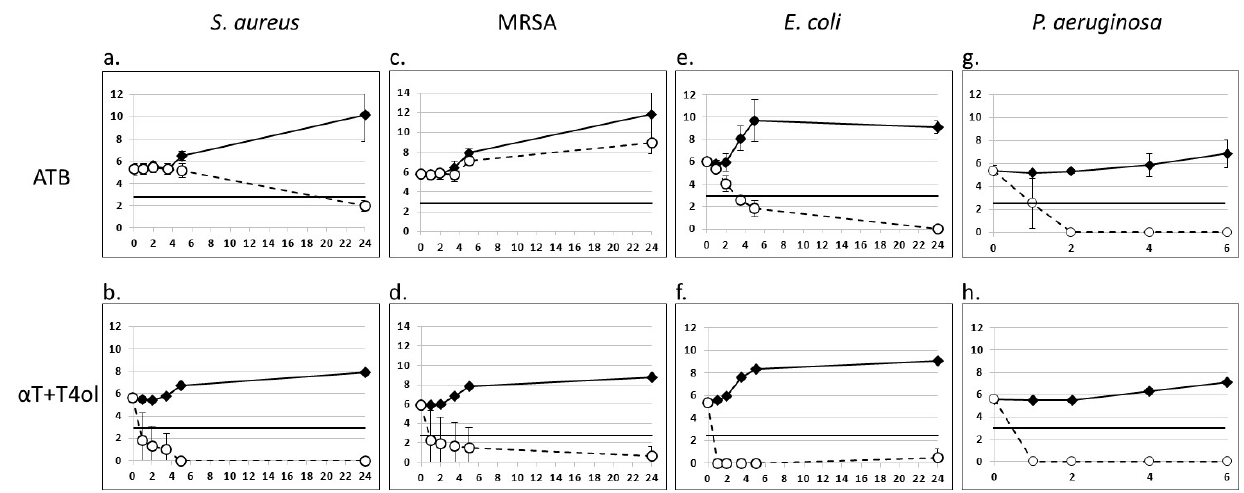
Figure 2. Time kill assays of Synterpicine™. Bacteria were incubated in the presence of ( a , c ): ampicillin; ( e ): amoxicillin; ( g ): gentamycin; ( b , d , f , h ): Synterpicine™. Black diamond: control; white circle: 4×MIC. The horizontal black line symbolizes the limit for a bactericide activity (>3 Log10 decrease). ATB: antibiotic (reference); α T+T4ol: Synterpicine™. x -axis: time (hours); y -axis: Log10 versus CFU/mL ( n = 2).